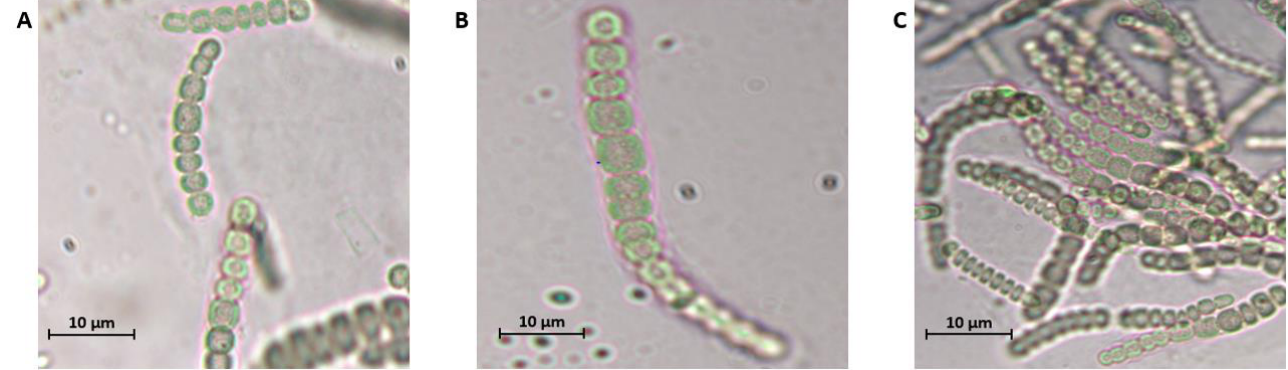
Figure 2. Microscopic observation of the three filamentous cyanobacteria species used in this study: ( A ) Roholtiella sp. (QUCCCM97), ( B ) Nostoc ellipsosporum (QUCCCM99), ( C ) Desmonostoc danxiaense (QUCCCM112).